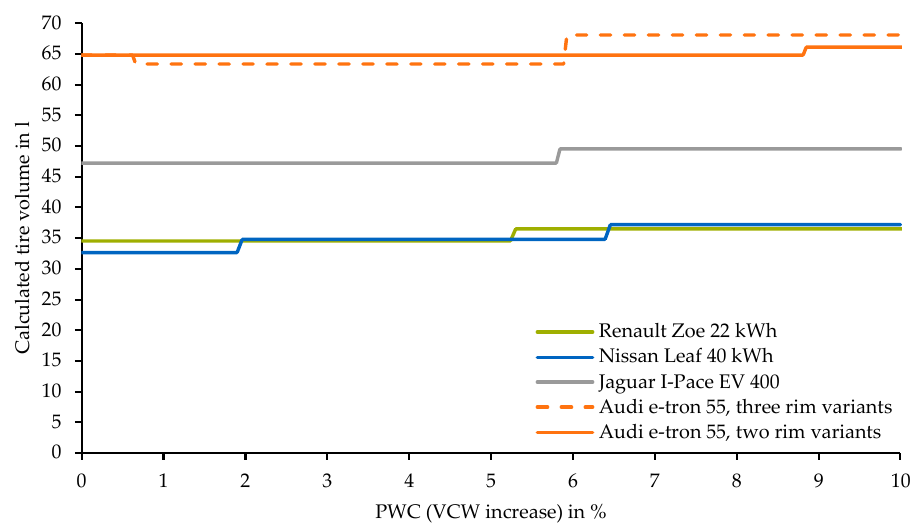
Figure 6. Interdependency between secondary volume change (SVC) of the wheel and the primary weight change (PWC).